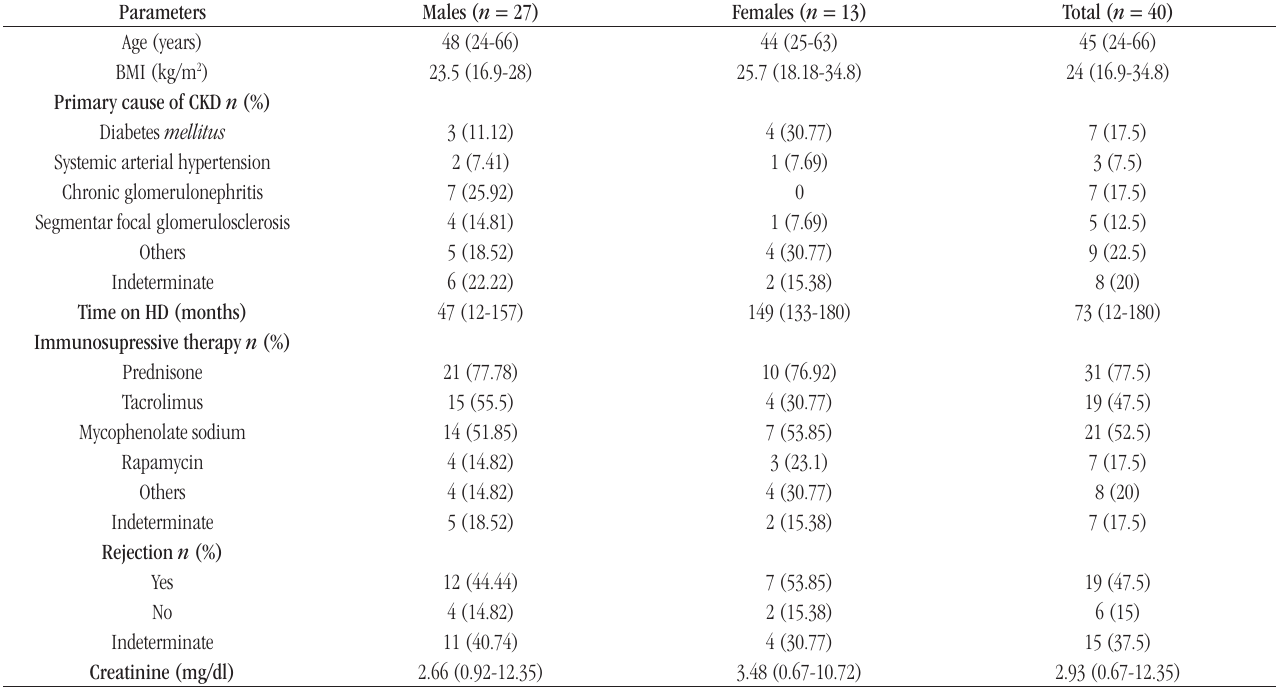
taBLE 1 − Clinical and laboratory information of kidney transplant patients in the study Parameters